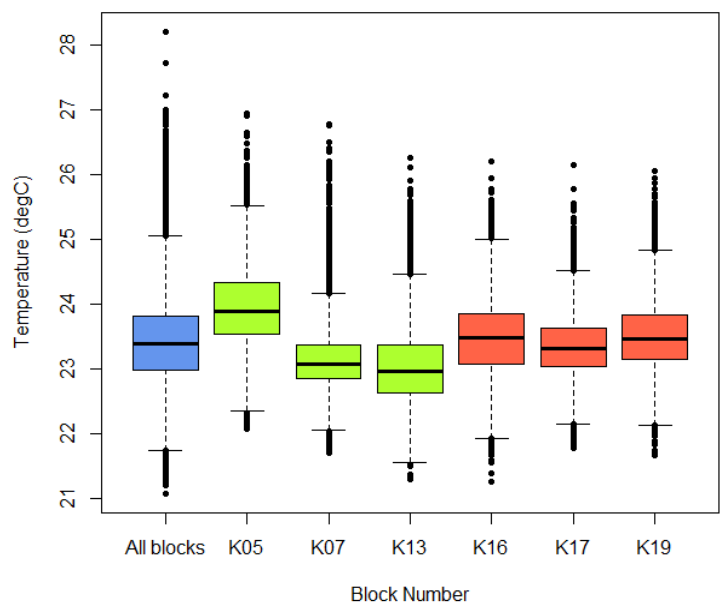
Figure 5. Boxplots of temperature for pixels defined as canopy using a buffer of 3 m and a height threshold of 4 m. The boxplot that is coloured blue shows the temperature for all blocks. The three test blocks in green (5, 7 and 13) are assumed healthy, and the three boxplots coloured red (16, 17 and 19) are unhealthy.